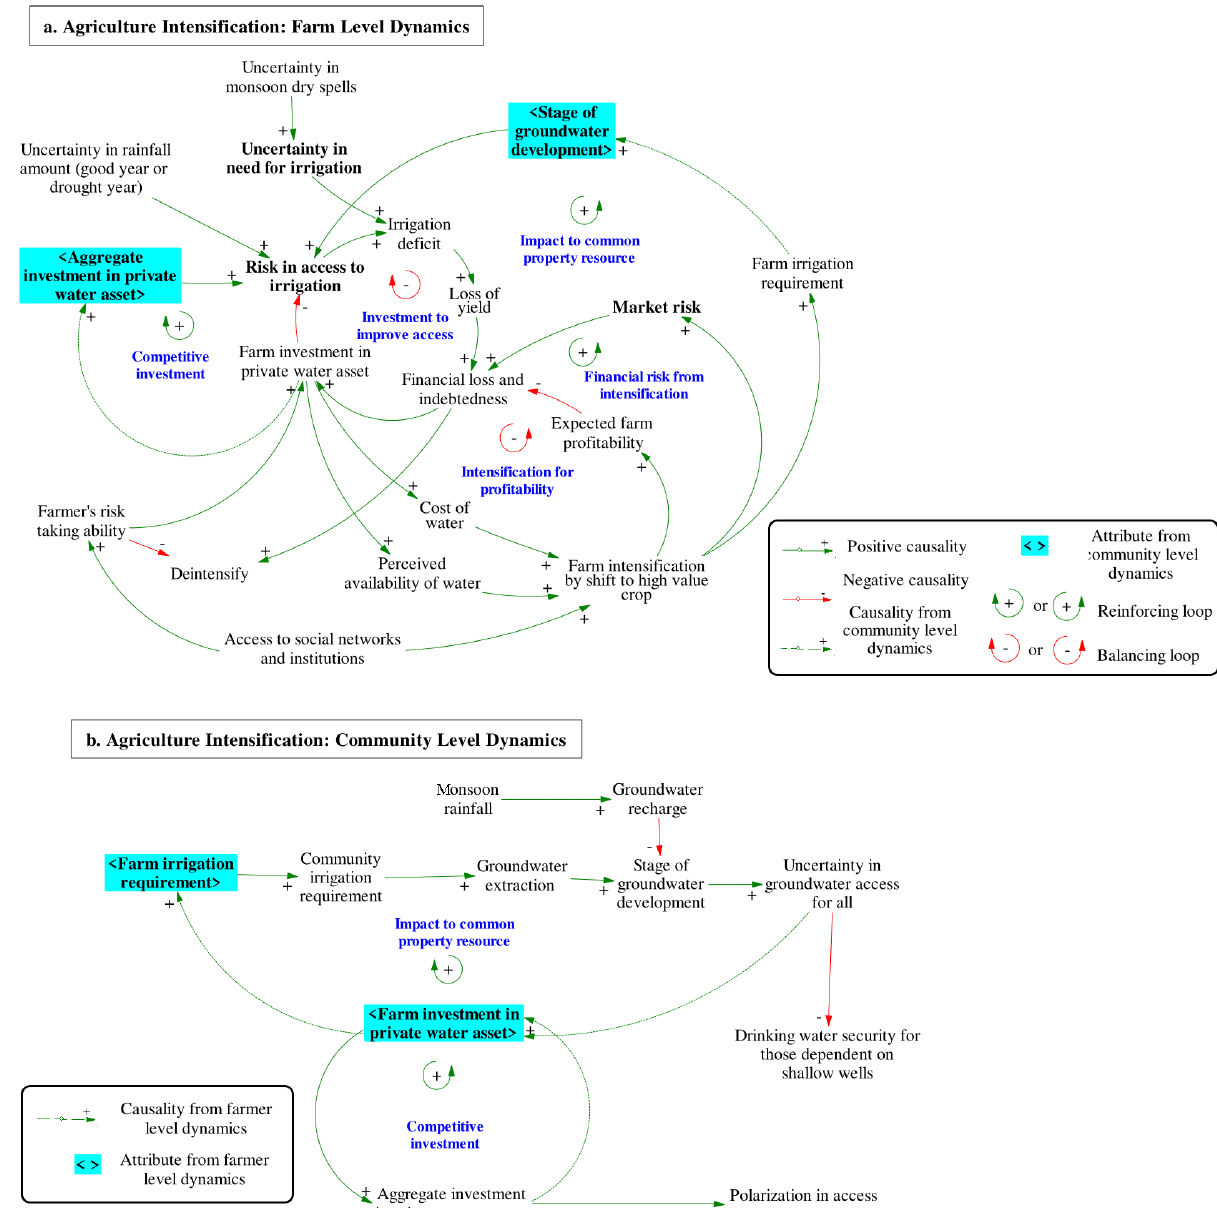
Fig. 6 . Two tier causal-loop diagram showing (a) farmer level and (b) community level dynamics of farmer decision making in response to social-ecological risks mediated through existing social and institutional networks. The actions of investment and intensification, which appear as risk mitigating or balancing loops for individual farmers, emerge as risk reinforcing loops at the community level. “Investment to improve access” (balancing) loop at farmer level emerges as “competitive investment” (reinforcing) loop at community level when many farmers start investing in water infrastructure. Similarly, the “intensification for profitability” (balancing) loop at farmer level leads to “impact to common property resource” (reinforcing) loop as the aggregated irrigation requirement for the community increases with intensification. The worsening of community level attributes (“stage of groundwater development” and “aggregate investment in private water asset”) in turn leads to higher risk for individual farmers resulting in a vicious cycle of investment and intensification, and as a result, greater farmer indebtedness. Farmers with poor social and institutional support are forced to deintensify and search for nonfarm employment. At the community level, there is rise in inequity in access to water and drinking water insecurity for those dependent on shallow public wells. Note that positive causality between two attributes (say, x and y) implies that when all other factors are held constant, an increase in x causes an increase in y (or decrease in x leads to decrease in y). Negative causality implies that increase in x causes a decrease in y, all other factors being